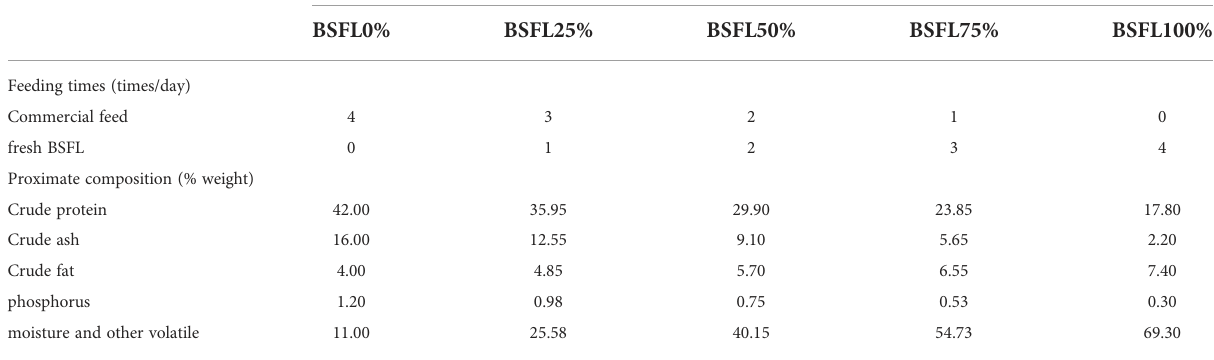
TABLE 2 Feeding times and proximate composition of the experimental